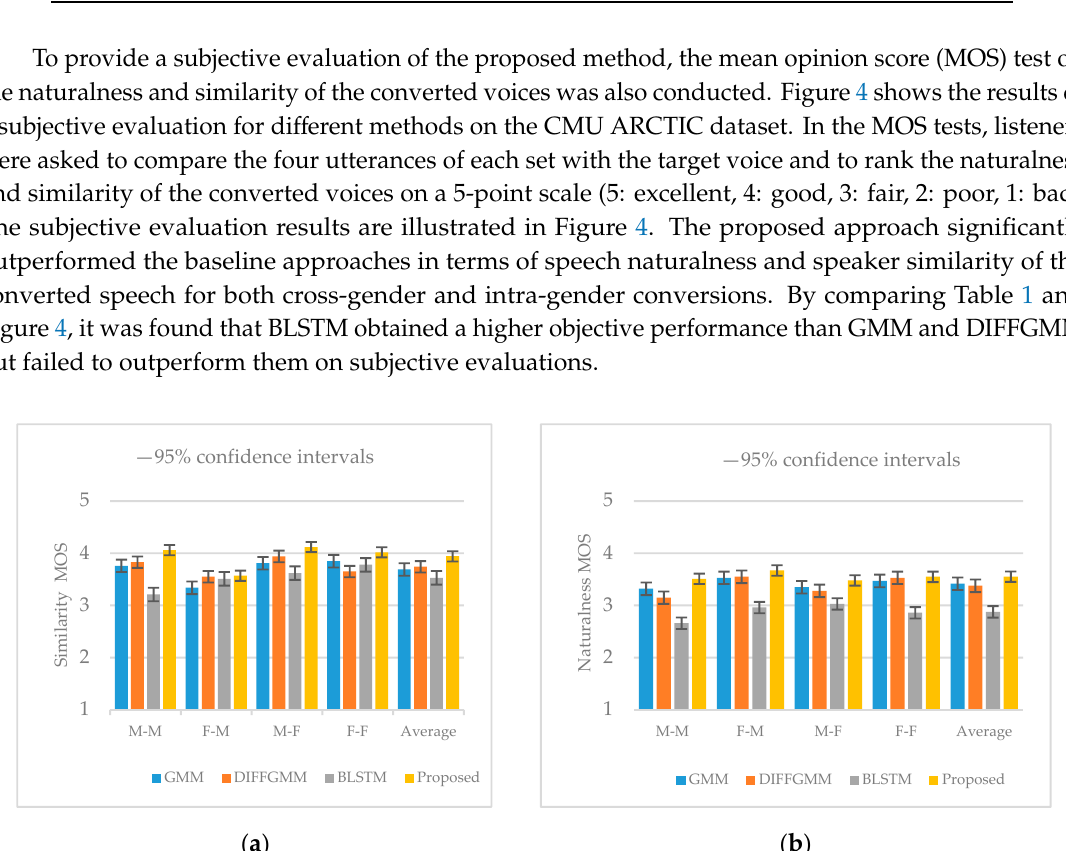
Table 2. Mean values of the MCD of all non-silent frames of the VC methods on the THCHS-30 dataset (15dB babble added to source).